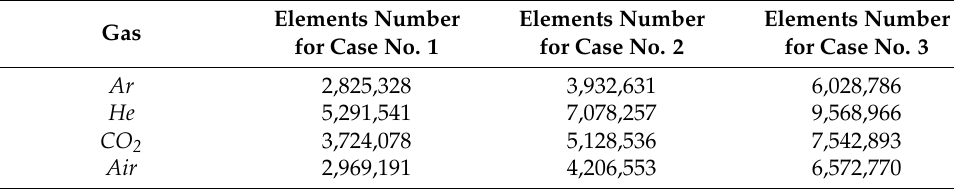
Table 4. Grid independence analysis for SVT with the same Reynolds number. Elements Number Elements Number Elements Number Gas for Case No. 1 for Case No. 2 for Case No. 3